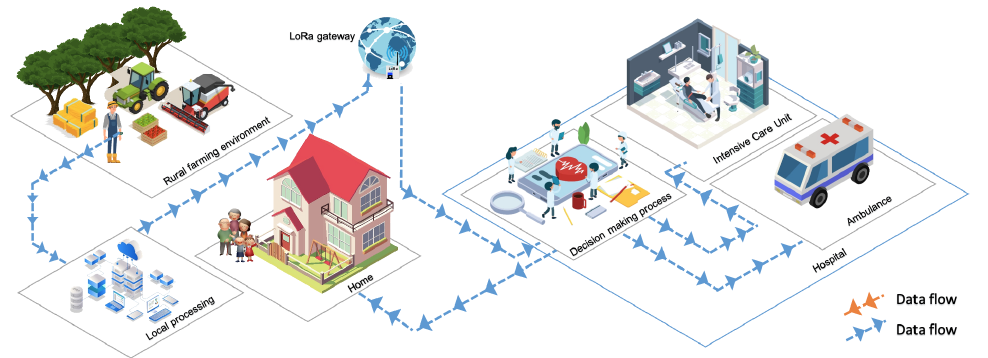
Figure 1. The Proposed farmer safety system in a smart farming